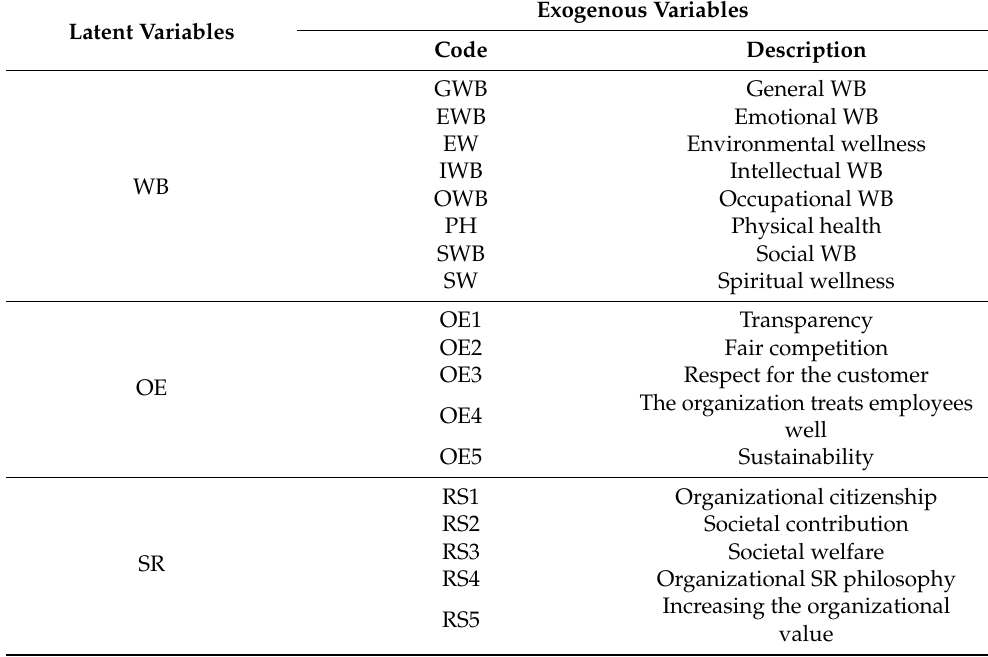
Table 2. Exogenous